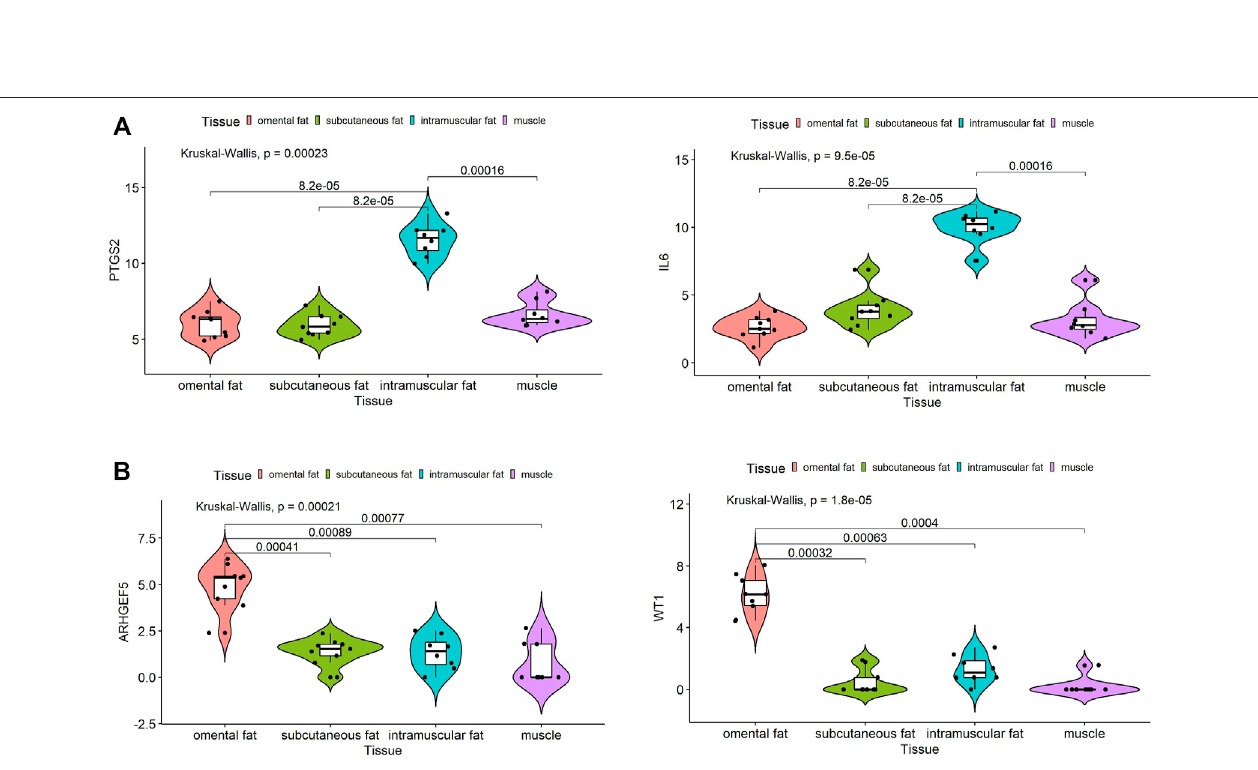
Frontiers in Genetics |